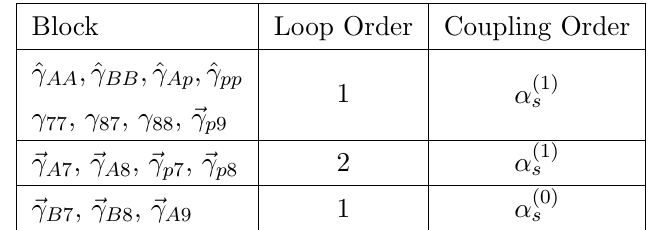
Table 1. Loop- and coupling-order of the leading contributions to the anomalous dimensions.